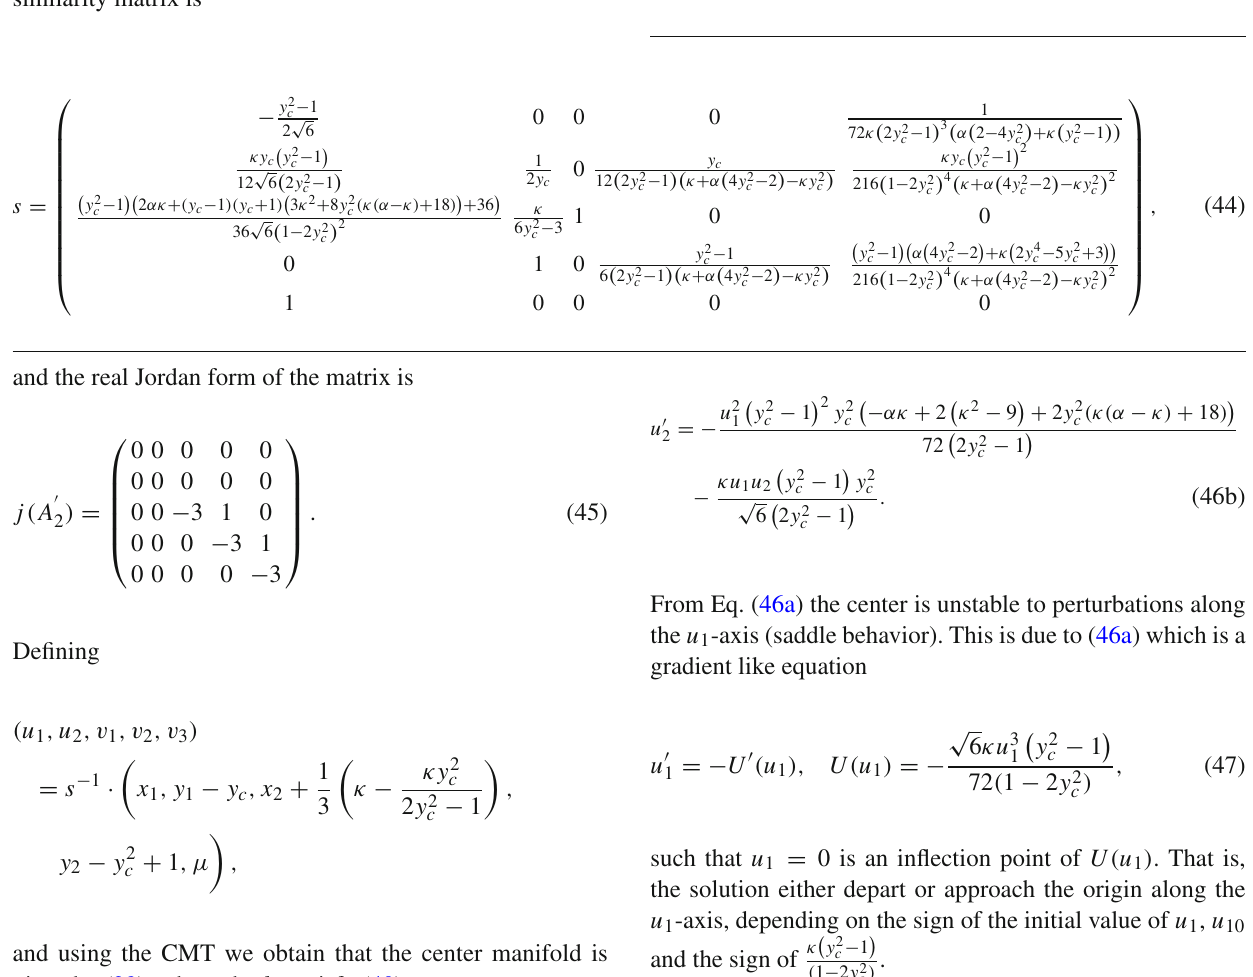
In Fig. 3 a phase plot of system (46) is presented for some values of the parameters showing that A